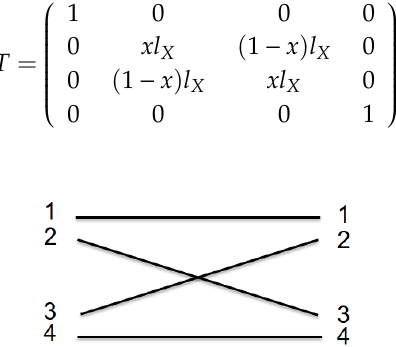
Figure A2. Example of an interconnection between 4 MZIs, used in 4 × 4 − Beneš .